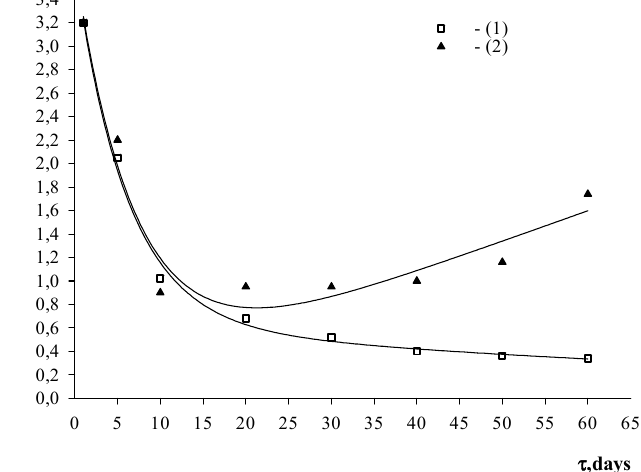
Figure 1. Variation of St3 (sample No. 1) corrosion rate in the solution containing NaCl. 1—in static conditions; 2—with agitation.